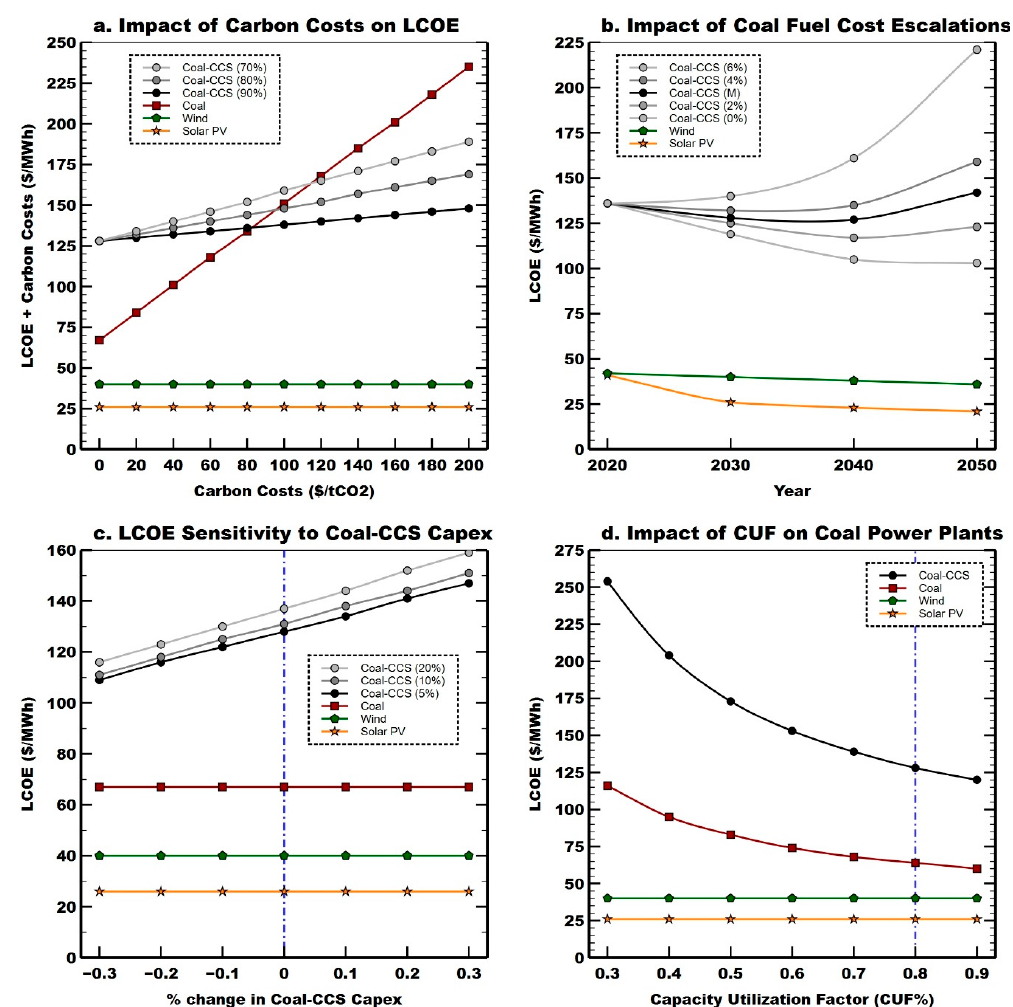
Figure 4. Sensitivity analyses: ( a ) The impact of carbon costs on the levelized costs of coal and coal-CCS in 2030 (mean values)—for coal-CCS, the three different trends show the additional effect of the carbon capture rate (90%/80%/70%); ( b ) The impact of coal fuel cost escalation rates on the LCOE projections of coal-CCS; note that the reductions in the LCOE are only due to technology learning rates and ‘M’ represents the mean coal fuel price trajectory assumed in this study; ( c ) Sensitivity of 2030 mean LCOE values to changes in overnight capital costs of coal-CCS—the three different trend lines for CCS indicate different cost overruns during power plant construction phase (5%/10%/20%); ( d ) Impact of CUF on the LCOE of coal based power plants. Note: The LCOE of solar PV and wind are kept constant at their 2030 mean estimates (with mean assumptions of 19% CUF for solar PV and 29% for wind); The blue dotted line in c and d indicate the mean LCOE values of coal-CCS estimated in this study.